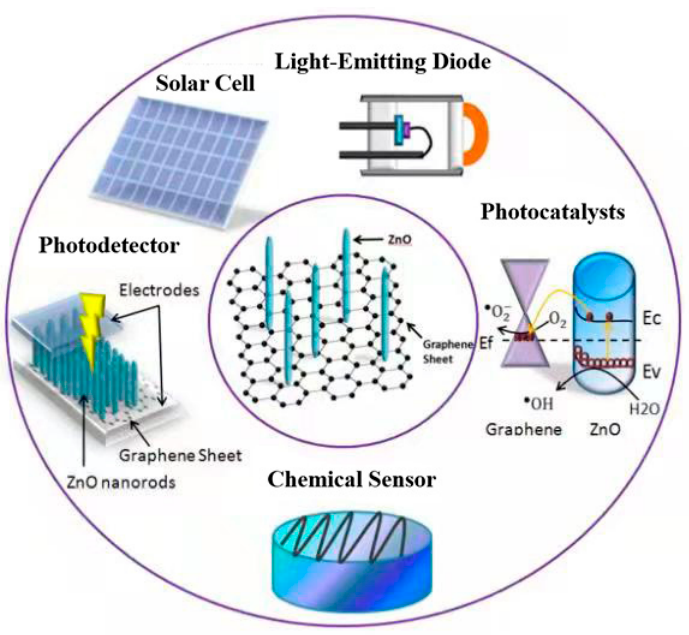
Figure 1. Application and development of ZnO–graphene nanocomposite structures.